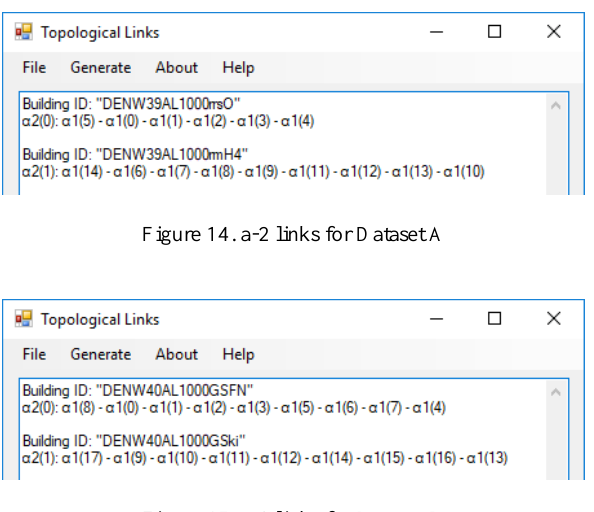
Figure 15. a-2 links for Dataset B